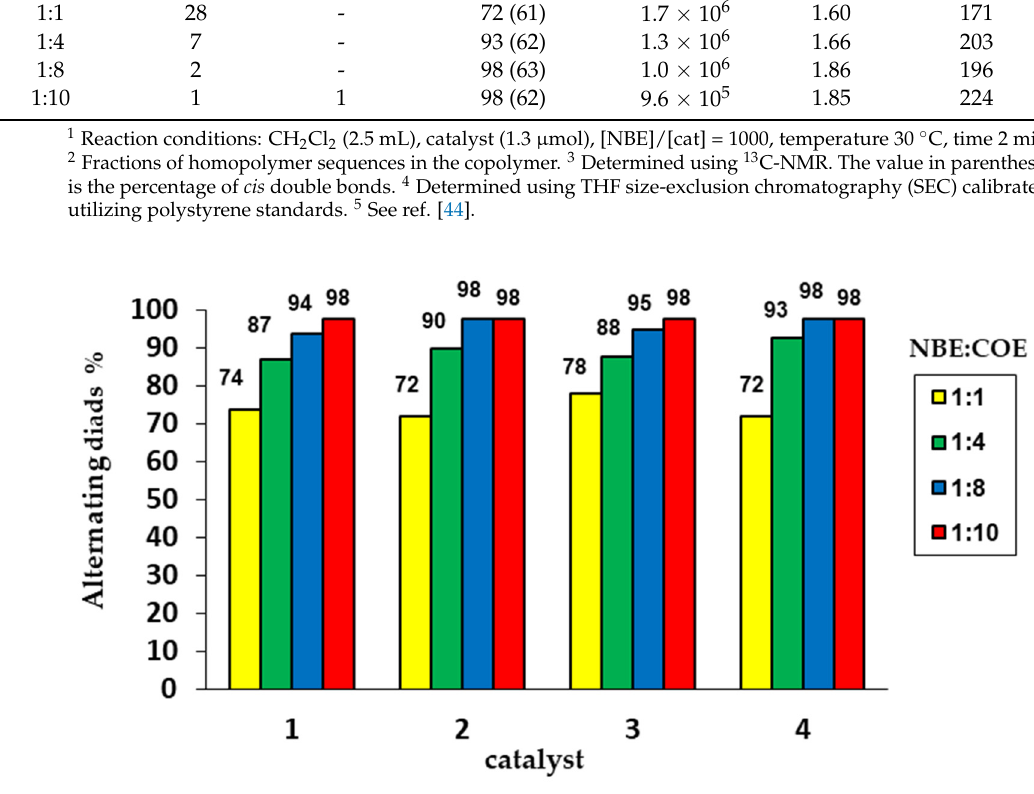
Figure 3. Content of alternating diads in the copolymers obtained at different ratios of NBE:COE (norbornene : cyclooctene).